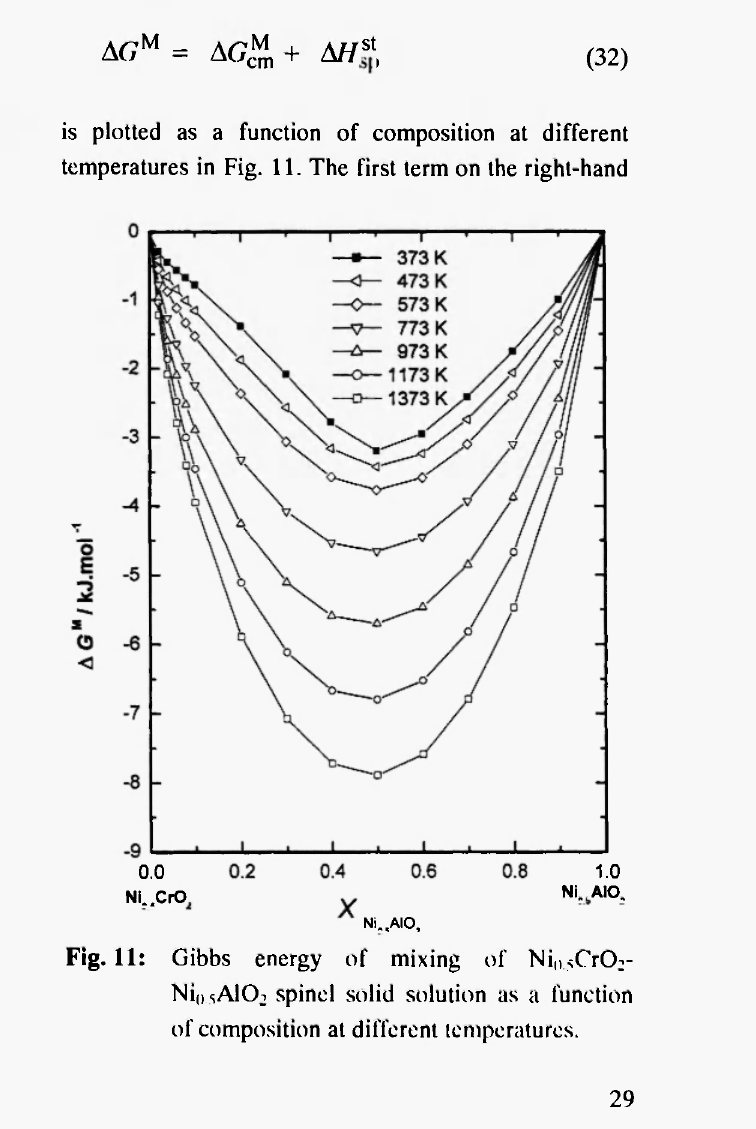
Fig. 10: Lattice strain enthalpy in spinel and corundum solid solutions with Cr + ' and AT 1 as the dissimilar